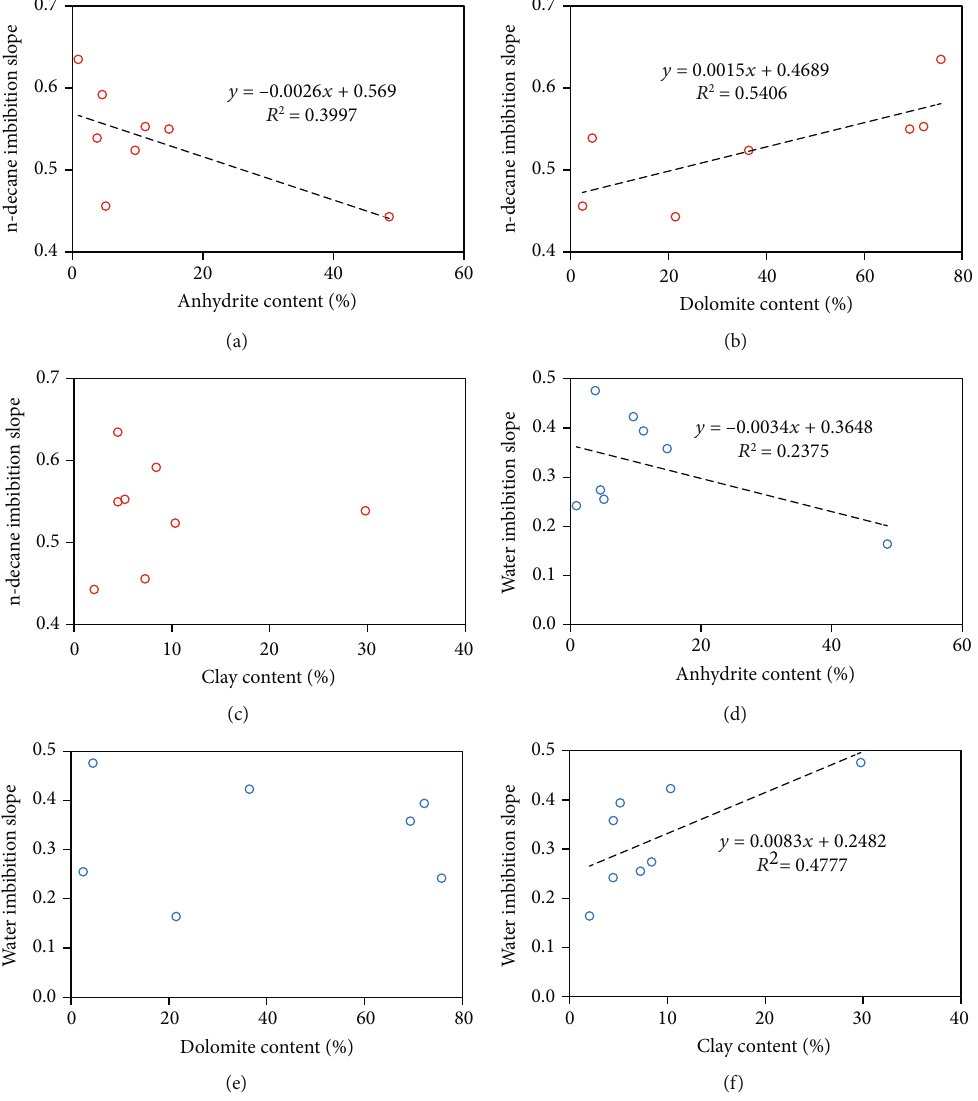
y = –0.0026 x + 0.569 R 2 = 0.3997